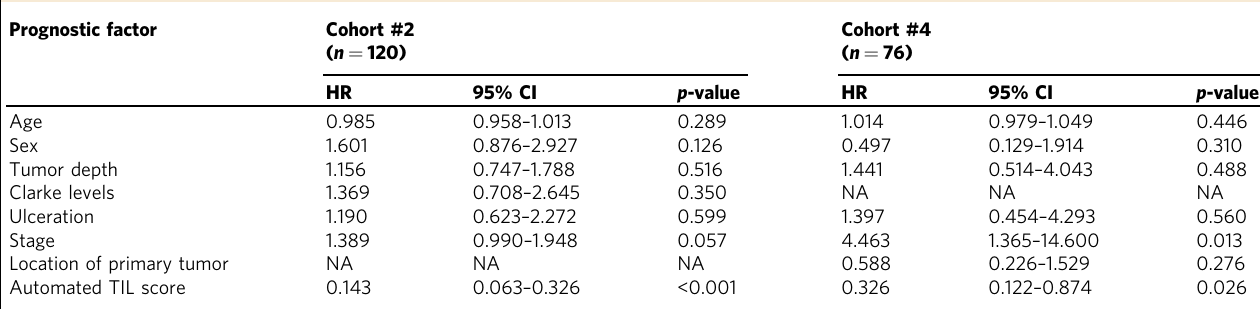
Table 1 Multivariate Cox-regression analysis of eTIL% score and the clinicopathological factors in whole-slide cohorts #2 and #4 regarding disease-speci fi c overall